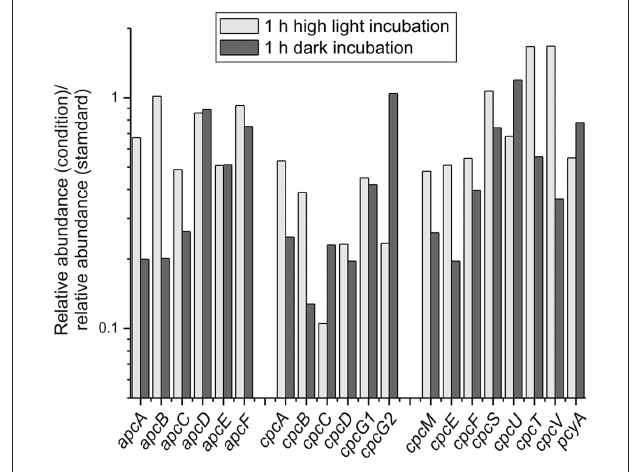
Figure 5 | Changes in transcript levels of genes encoding phycobiliproteins, linker polypeptides, and enzymes specifically involved in their biogenesis/maturation. The transcript levels for genes encoding phycobiliproteins, linker polypeptides, and enzymes involved in phycobiliprotein biogenesis/maturation are displayed as the ratio of the relative transcript abundances for cells exposed to high light for 1 h (light gray) or incubated under dark oxic conditions for 1 h (dark gray) compared to the mean of abundances for three standard conditions